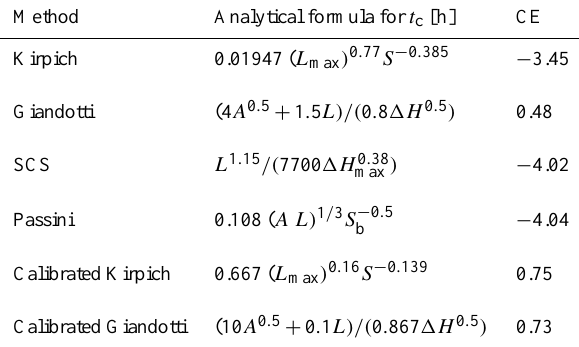
Table 2. Performance of various regional formulas for the time of concentration, t c , in terms of coefficient of efficiency (CE) against 32 large flood events in Cyprus ( L max : maximum length of main channel in km; S : main channel slope; A : basin area in km 2 ; 1H : elevation difference between the centroid of the basin and its out- let in m; 1H max : maximum elevation difference in m; S b : average slope of the